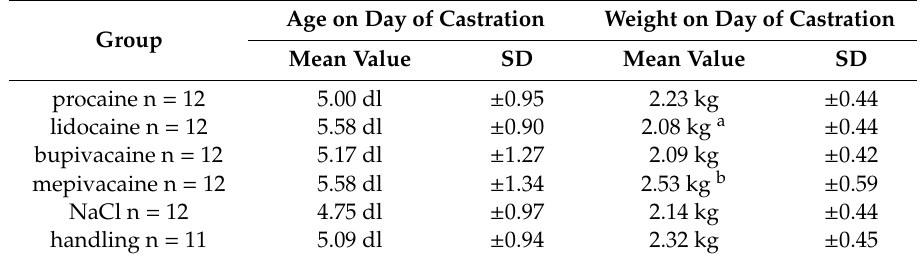
Table 2. Mean values and standard deviation of age and body weight on day of castration.